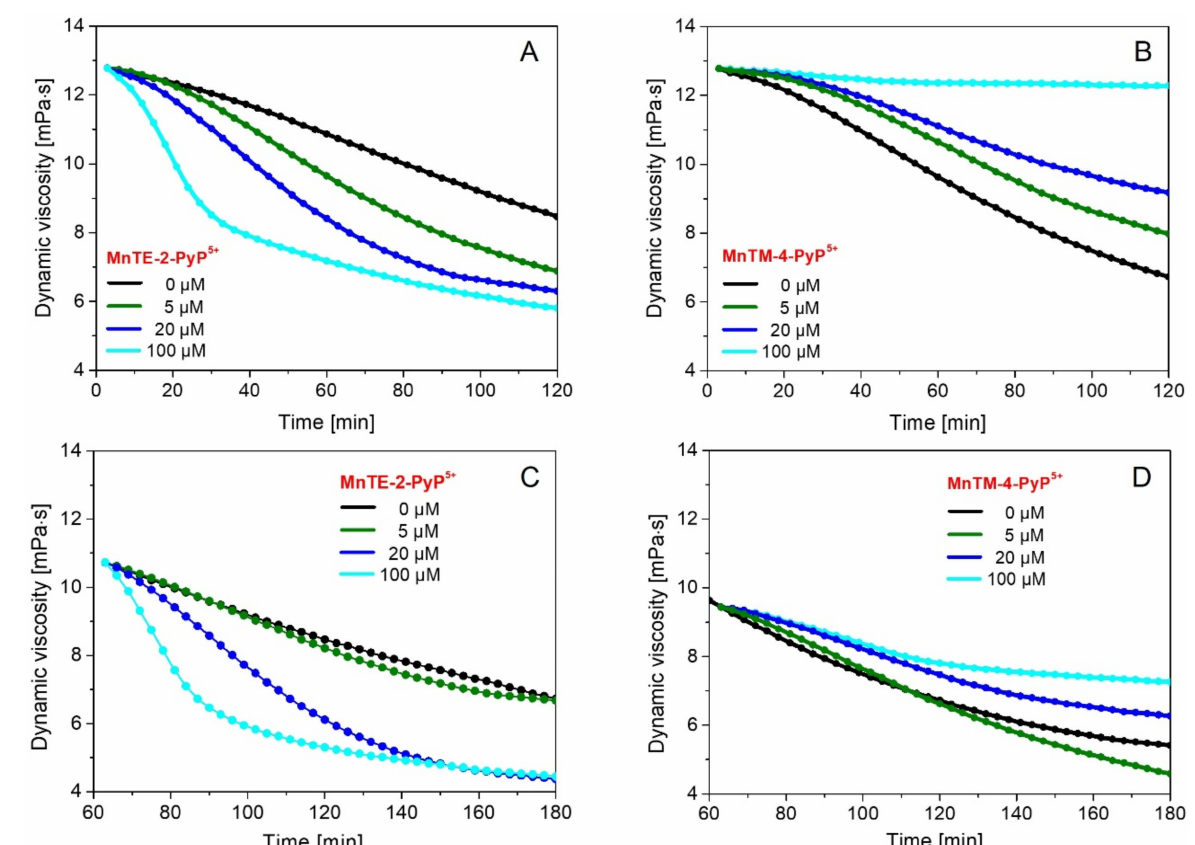
Figure 2. Time-dependent changes in dynamic viscosity of the HA solution subjected to 1 µ M Cu(II) and 100 µ M ascorbate in the presence of ( A ) MnTE-2-PyP 5+ or ( B ) MnTM-4-PyP 5+ at different concentrations: 0 (black curve), 5 (green curve), 20 (blue curve), and 100 µ M (cyan curve). The concentration of HA was 1.75 mg/mL. Panel ( C )—MnTE-2-PyP 5+ was added at 1 h after HA degradation began. Panel ( D )—MnTM-4-PyP 5+ was added at 1 h after HA degradation